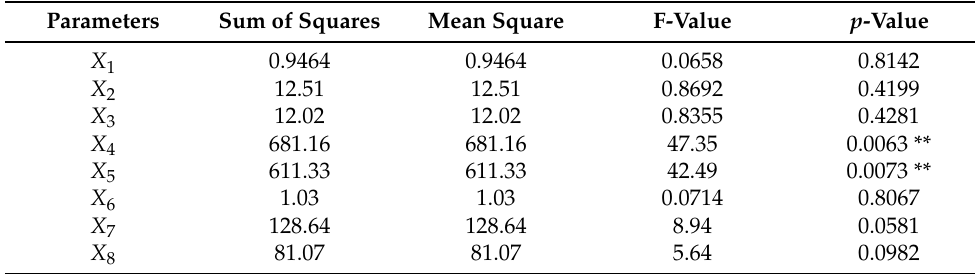
Table 6. Significance analysis of Plackett–Burman test